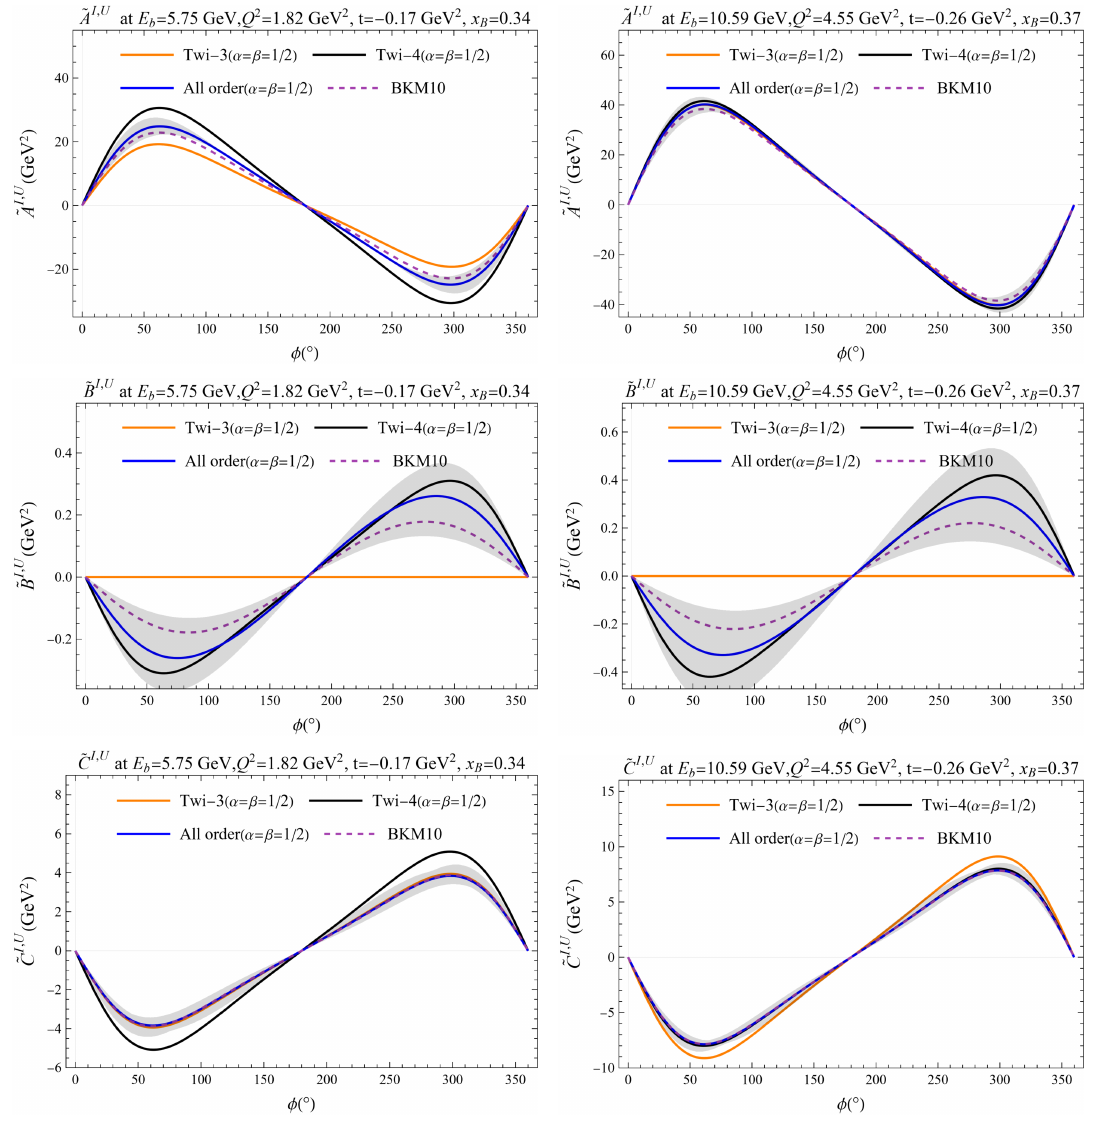
Figure 8 . Comparison of the coefficients ˜ A I, U , ˜ B I, U , ˜ C I, U from light cone calculation with the BKM10 result.The orange line stands for the results with only twist-three kinematical accuracy, the black line has twist-four kinematical accuracy, while the blue line contains kinematics of all order. The dashed line is the BKM10 result. The gray band consists of all possible values of those coefficients with 0 ≤ α ≤ 1 and 0 ≤ β ≤ 2